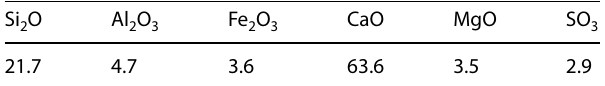
Table 3 The total chemical compositions (in percent) of cement agent Si O Al 2